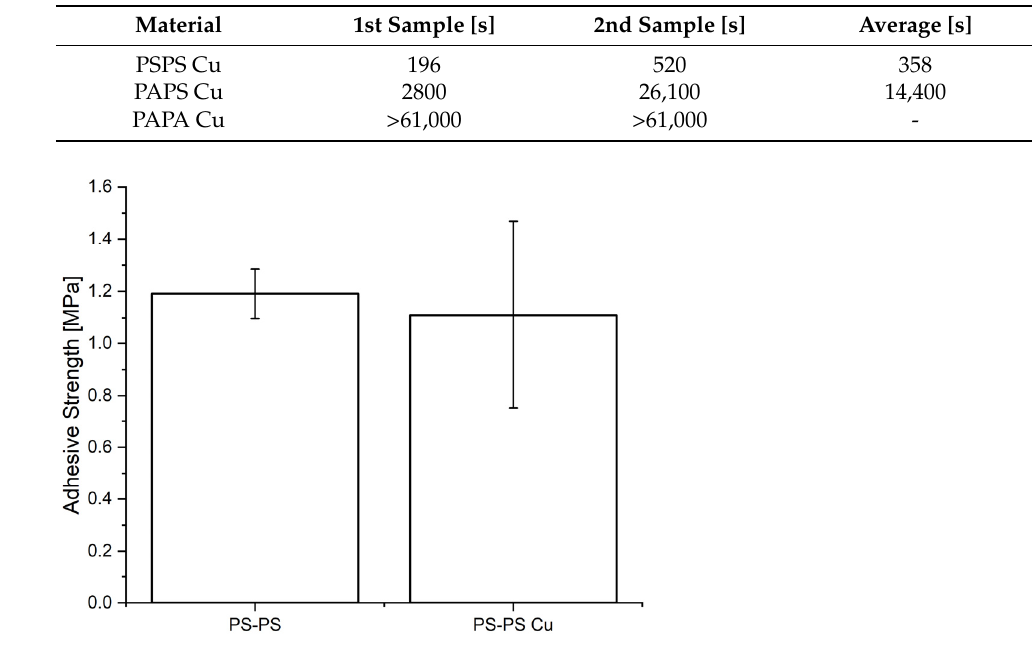
Figure 6. Comparison of adhesive strength measured with a LUMifrac device between PS–PS without and with copper(II) ions adsorbed to the surface before bonding. PS–PS represents a joint of two PS specimens. Each experiment was performed with four samples. The error bars indicate the standard deviation.